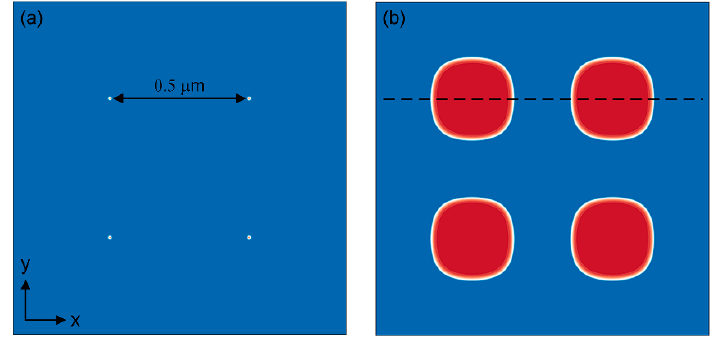
Figure 11. The regular alignment of γ (cid:48) phase at t = 0 ( a ) and microstructure after 1120 ◦ C / 2 h ( b ).